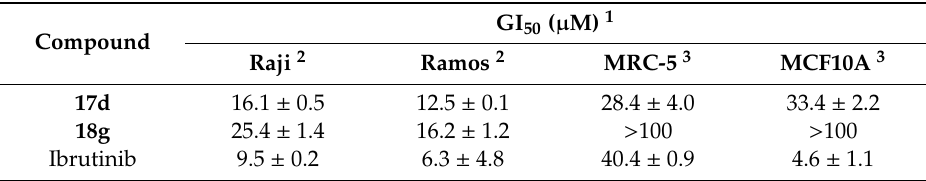
Table 4. In vitro cell growth inhibitory activity of 17d and 18g .